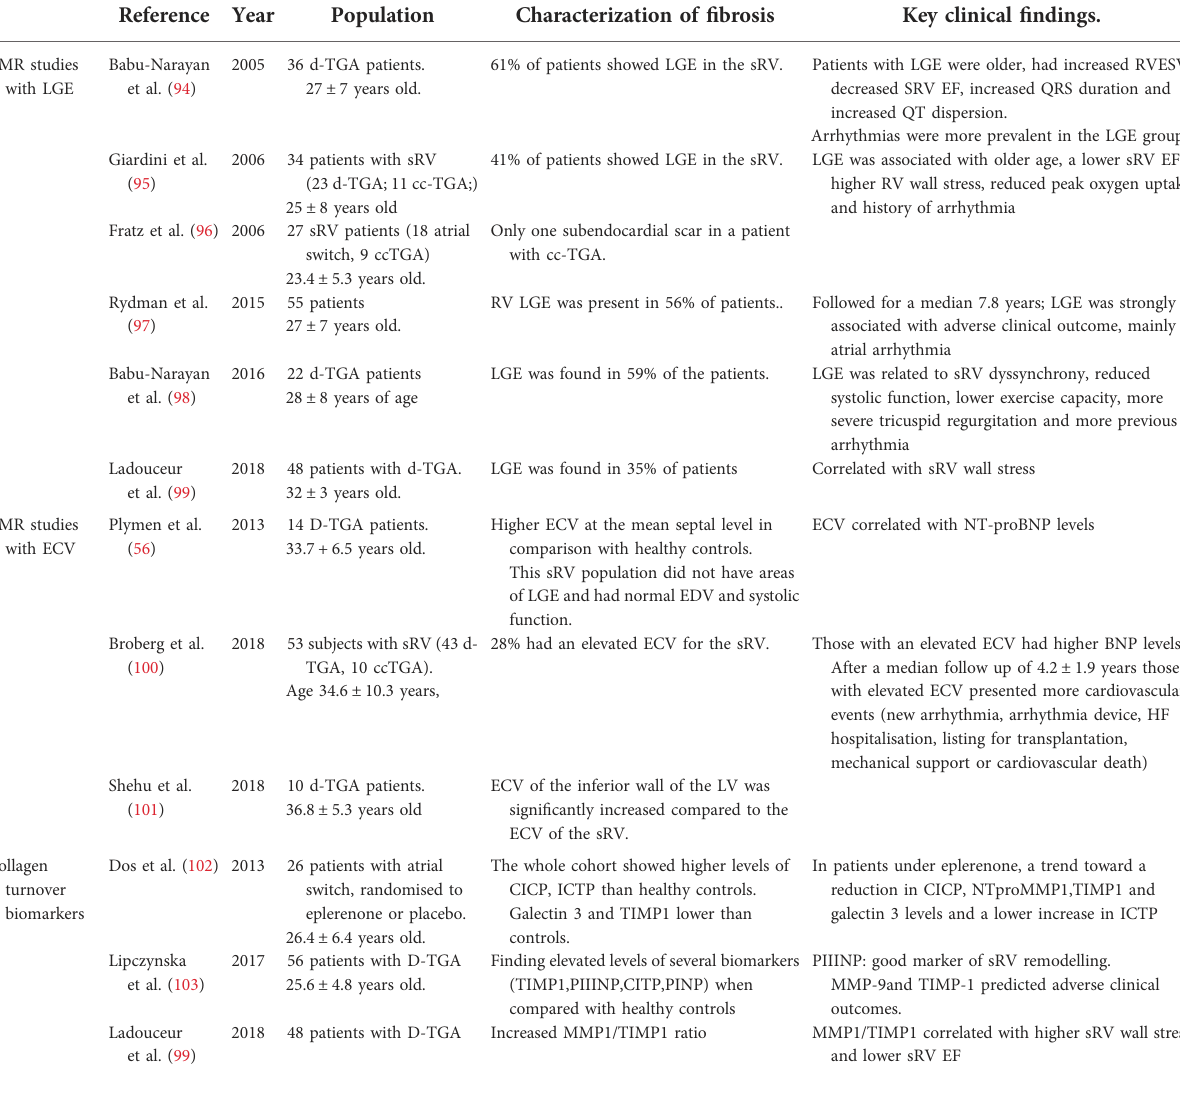
TABLE 2 Most relevant studies characterizing myocardial interstitial fi brosis with cardiac magnetic resonance and collagen turnover biomarkers in patients with systemic right ventricle.